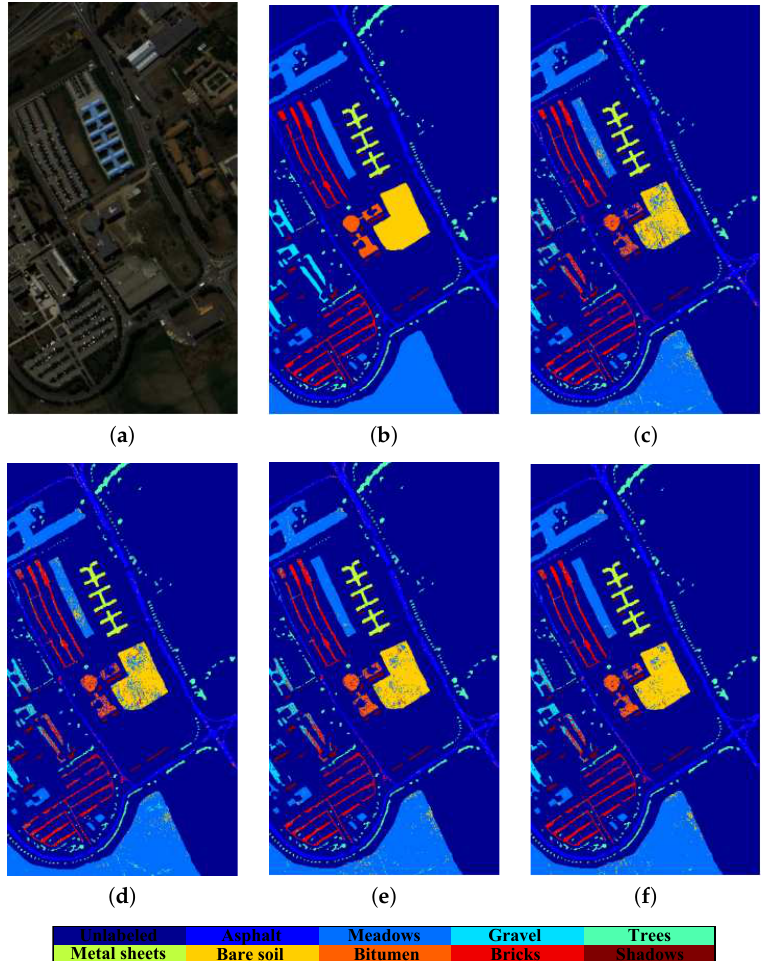
Figure 6. Thematic maps resulting from classification for the University of Pavia dataset with nine classes. ( a ) pseudo-color image; ( b ) ground truth map; ( c ) LDA: 90.51%; ( d ) SLPP: 89.09%; ( e ) SGDA: 92.56%; ( f ) GDA-SS: 94.02 %. Statistical significance from the Standardized McNemar’s Test about the difference between